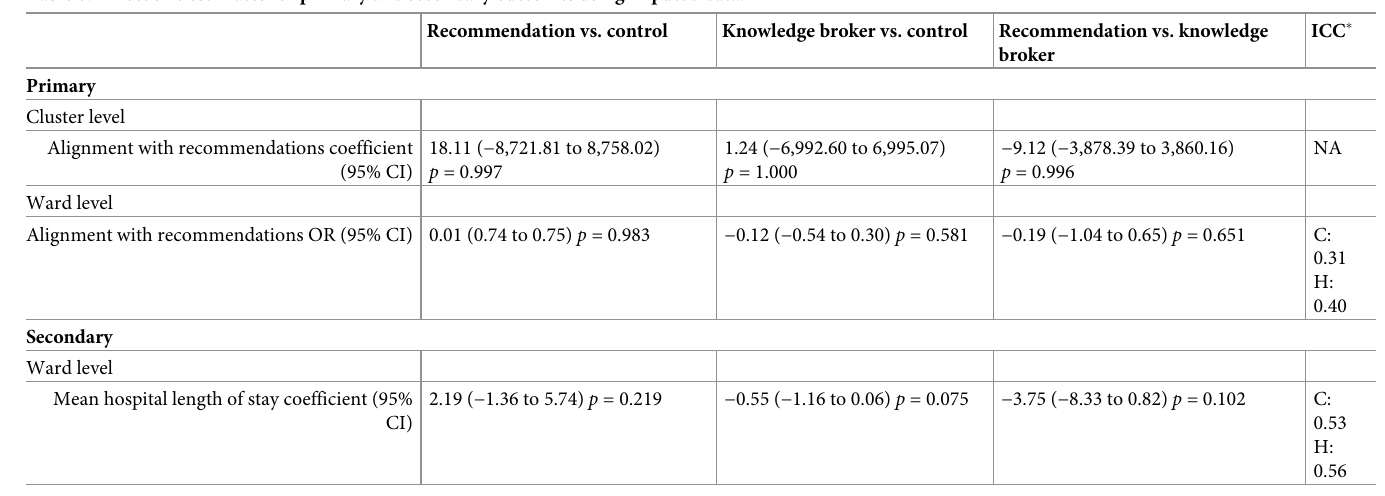
Table 6. Effect size estimates for primary and secondary outcomes using imputed data. Recommendation vs. control